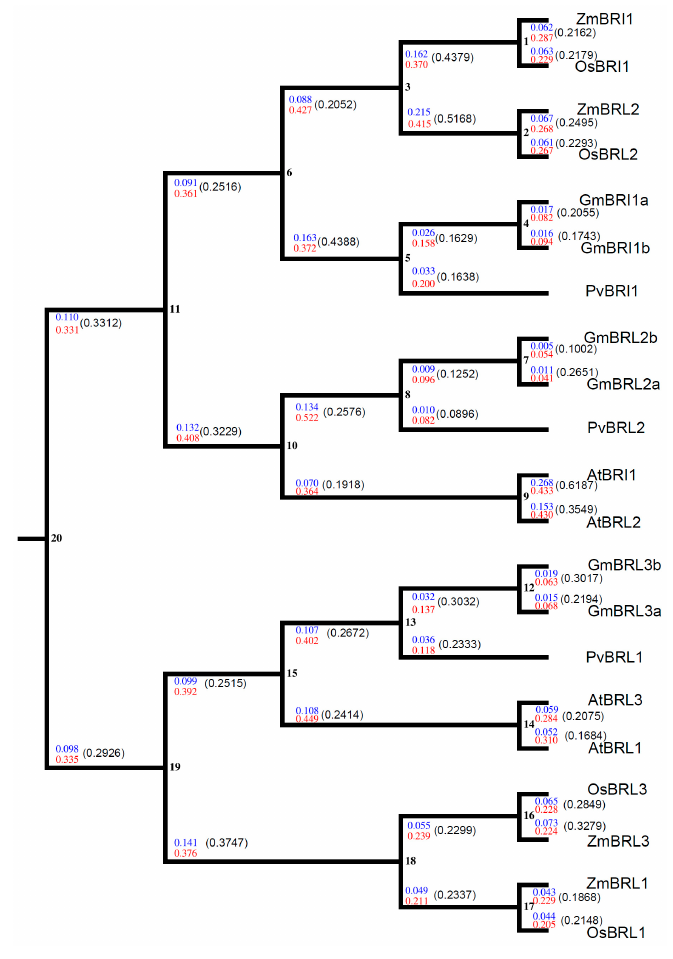
Figure 11. Estimation of K a / K s in the BR receptor genes from soybean, common bean, Arabidopsis, rice, and maize. The cDNA sequences and amino acid sequences of the BR receptors from dicots (soybean, common bean, and Arabidopsis ) and monocots (rice and maize) were used to estimate the K a / K s . Twenty nodes are shown. The K a and K s values in each node and branch are marked in blue and red, respectively. The K a / K s in each branch is indicated in parentheses and all K a / K s values were less than 1.0.